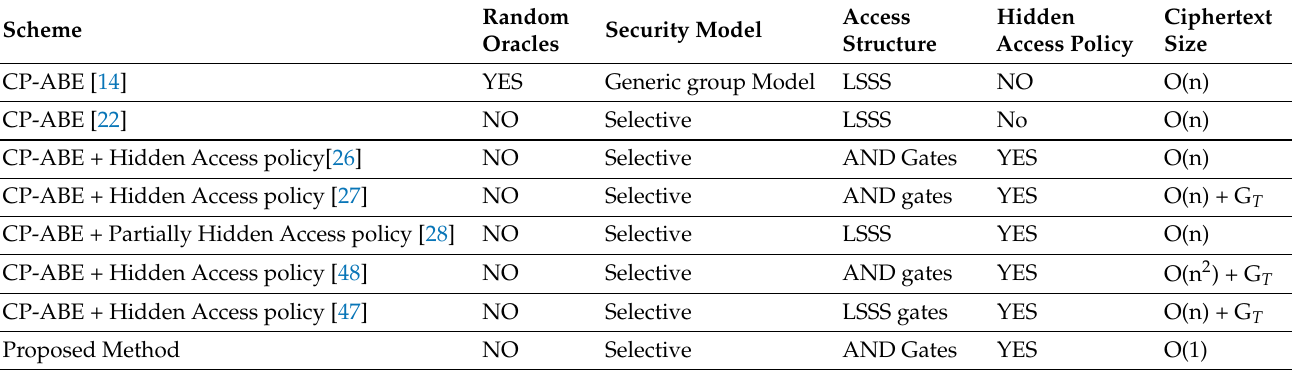
Table 10. Comparison among different CP-ABE